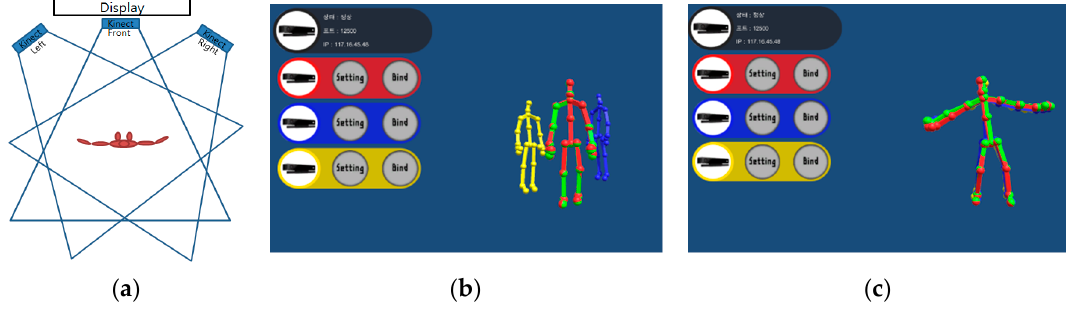
Figure 5. ( a ) The placement layout of multiple Kinects, ( b ) before and ( c ) after calibration.